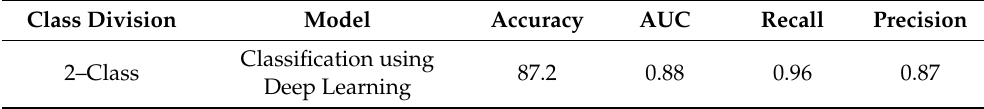
Table 3. Classification performance analysis—Deep